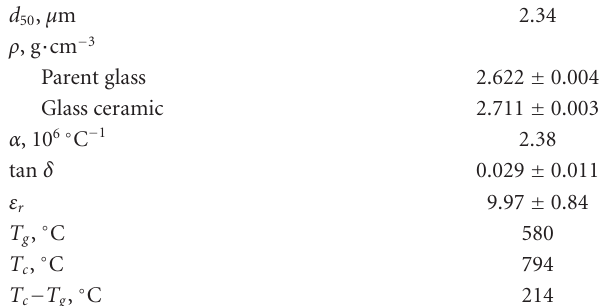
Figure 3: Relative density versus temperature of the selected glass. Table 2: Properties of the investigated LZSA glass ceramic (sintered at 850 ◦ C for 10min).